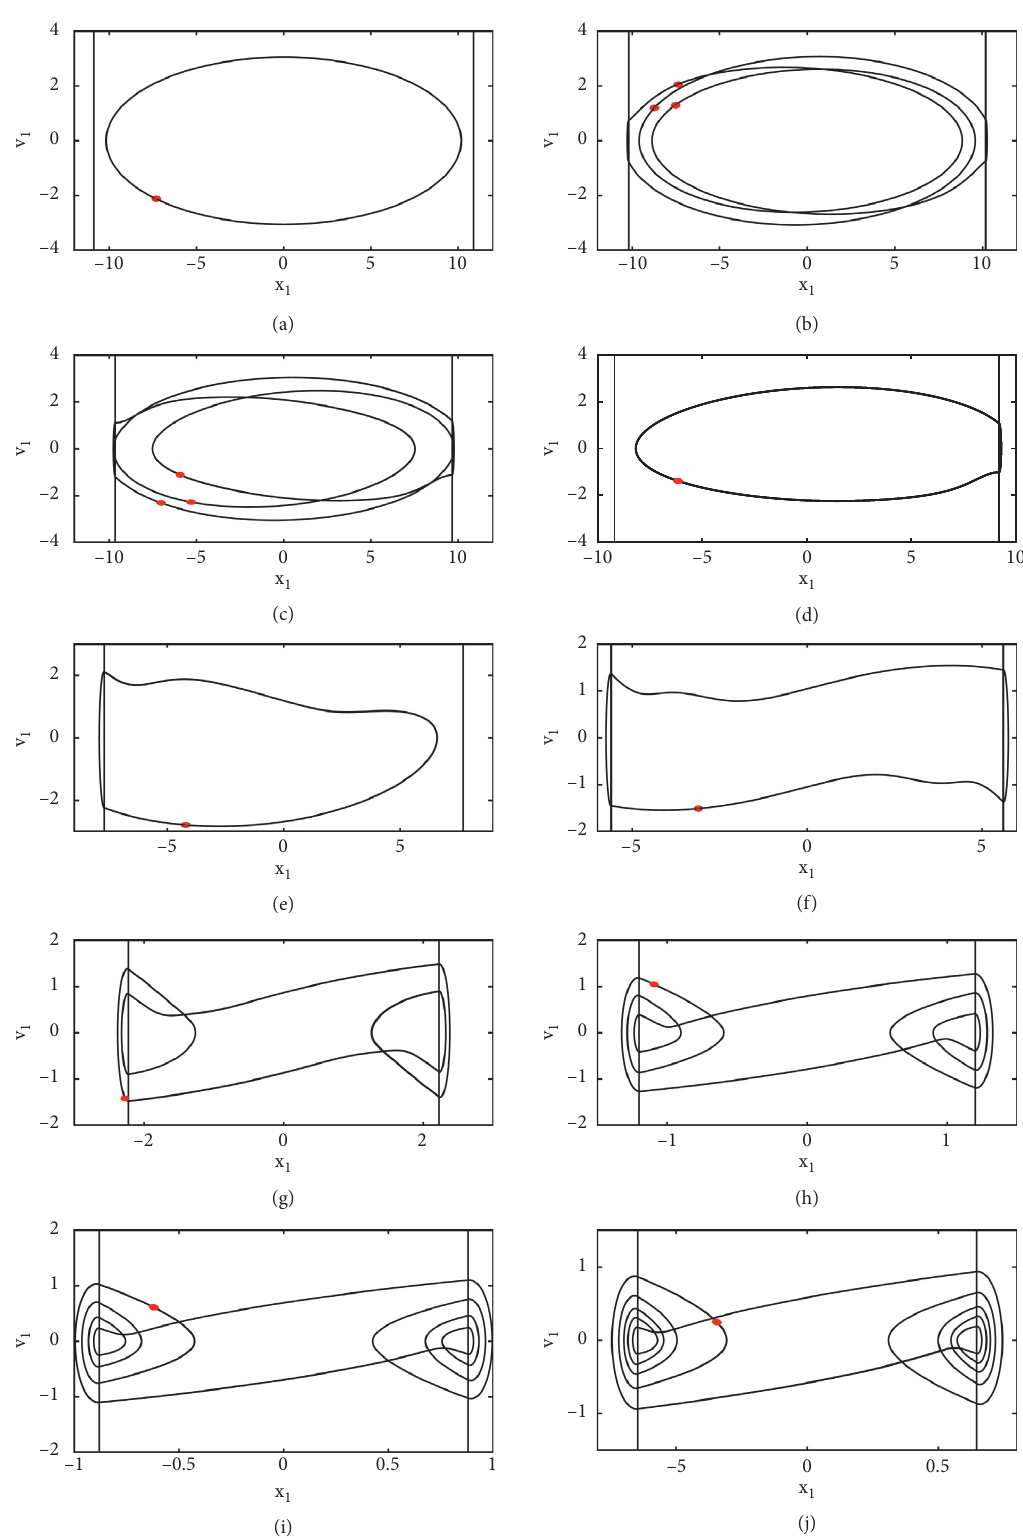
Figure 10: The phase diagrams in (a)-(j) correspond to the periodic motions of regions (j)-(s) in Figure 8, respectively. Poincare sections are marked by red dots on the phase